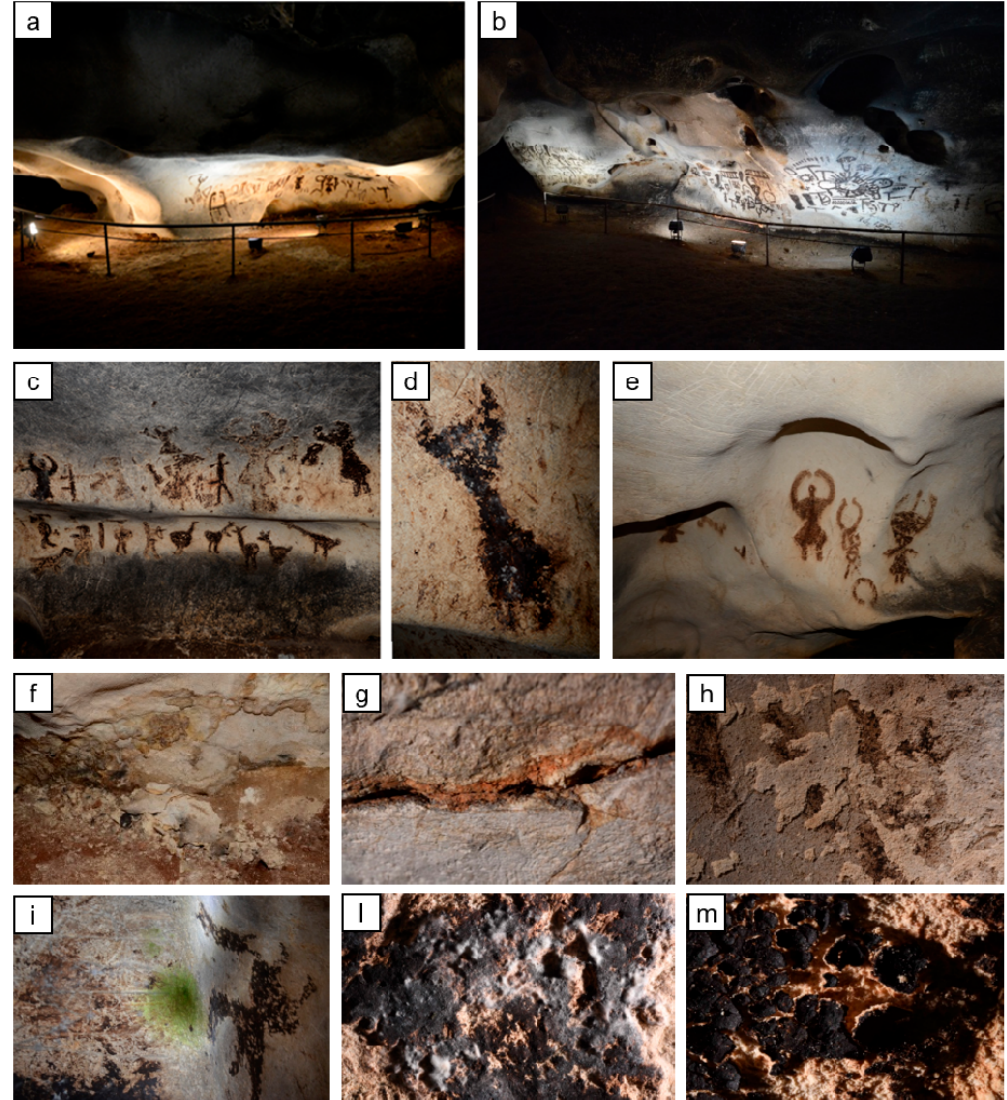
Figure 1. General view of the Gallery with the paintings in the Magura cave (Bulgaria) ( a , b ), details of the cave paintings ( c , d , e ), and details of the deterioration patterns (( f , g , h )—cracks, powdering, blistering, and fragmentation of the limestone; ( i , l )—biological colonization; ( m )—cracking and loss of the original guano painting due to the drying of the surface and powdering of the stone).